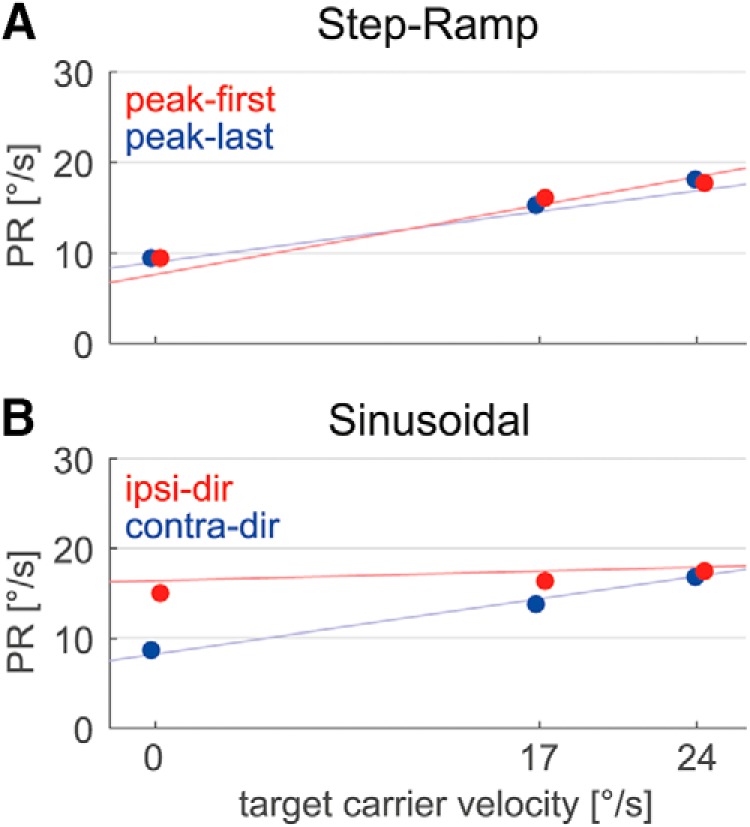
PRs for the bounded PD-controller model. A, In step-ramp, perturbations were either peak-first (red) or peak-last (blue). B, During sinusoidal pursuit, perturbations were classified as ipsidirectional (red) or contradirectional (blue). Regression lines from Figure 6 are shown for comparison.